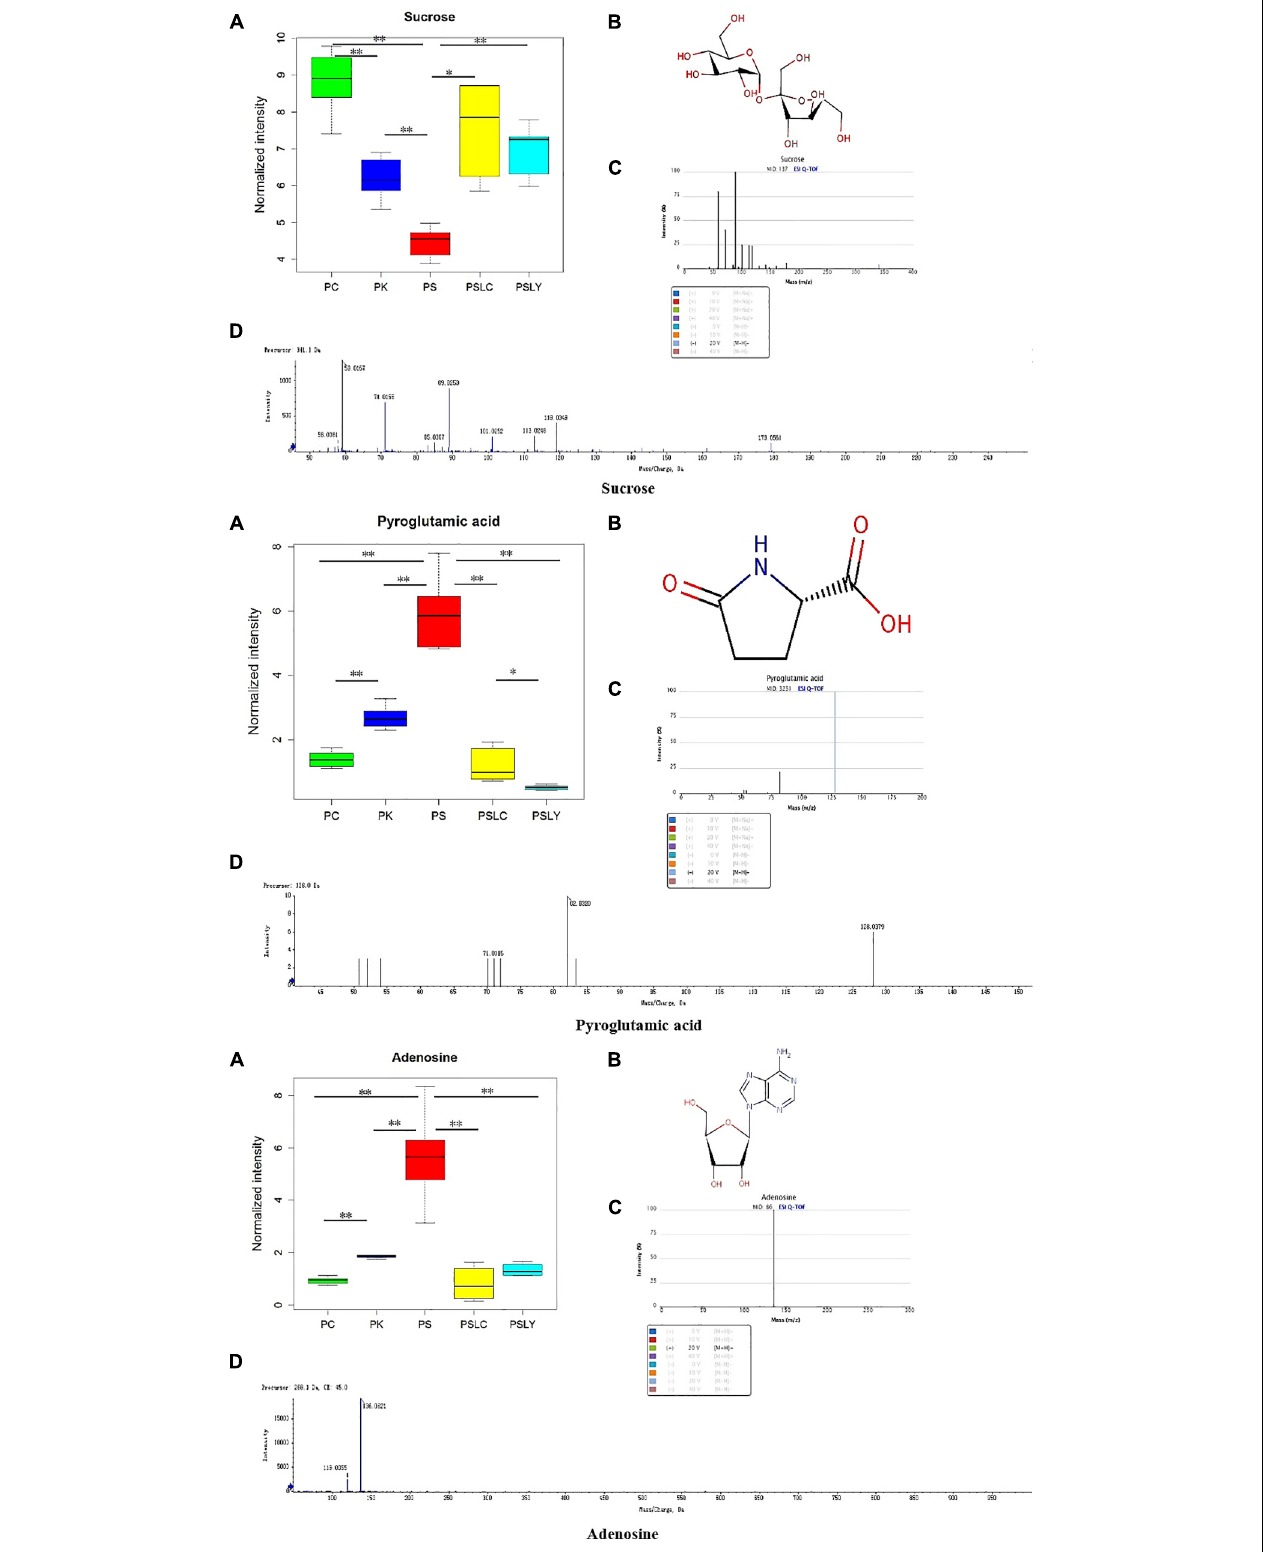
FIGURE 6 | Box diagram, spectra, and structural formulas of novel markers. (A) Box diagram. (B) Structural formulas. (C) Standard spectra of novel markers. (D) Detection spectra of novel markers. ∗ represents significant differences, ∗∗ represents extremely significant differences.